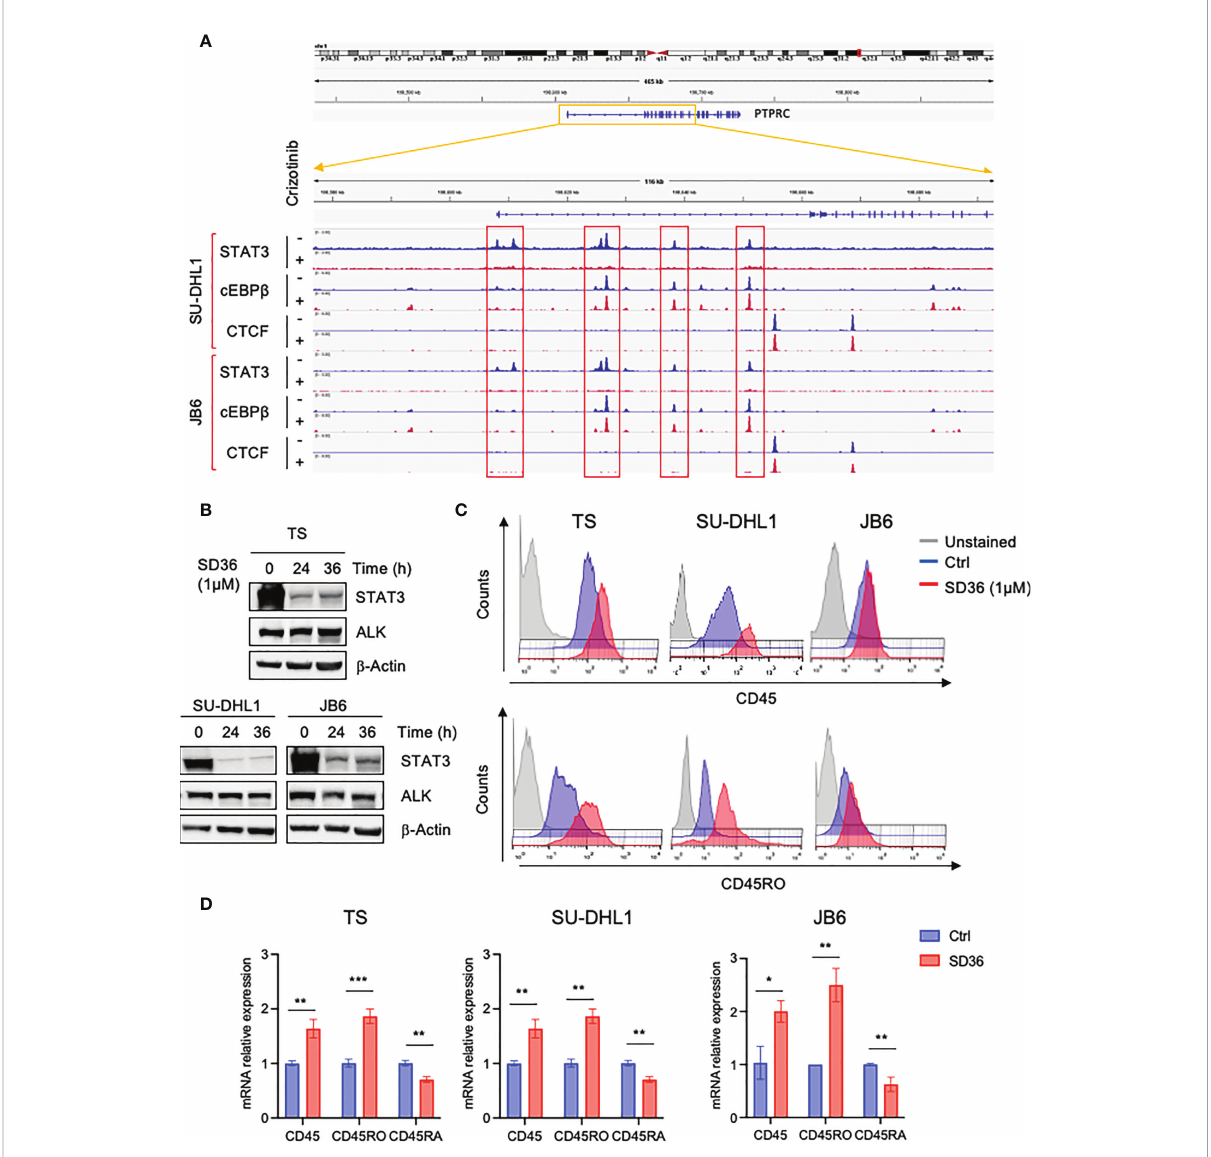
FIGURE 3 CD45 and CD45RO are derepressed by ALK via STAT3. (A) STAT3, C/EBP- b and CTCF ChIP-seq tracks at CCR7 gene on two representative ALK + ALCL human cell lines (JB6 and SU-DHL1) treated with crizotinib (300 nM) for 3h. Experiment was performed one time on two independent cell lines with similar results. (B) Immunoblot analysis performed on three ALK+ ALCL cells (TS, SU-DHL1 and JB6) treated with STAT3 degrader SD36 (1 m M) for the indicated time-points. Total cell lysates were blotted with the indicated antibodies. b -actin was used as a loading control. A representative Western blot out of two is shown for each cell line. (C) CD45 and CD45RO cell surface expression intensity in ALK+ ALCL cell lines (TS, SU-DHL1 and JB6) treated with STAT3 degrader SD36 (1 m M). TS and JB6 cells were treated for 48h and SU-DHL1 for 36h. A representative experiment out of two is shown for each cell line. (D) qRT-PCR analysis of CD45, CD45RO, CD45RA mRNA expression performed on ALK+ ALCL cell lines treated with STAT3 degrader SD36 (1 m M) for 36h. n=3 technical replicates. Data are shown as mean ± s.d. *P<0.05, **P<0.01, ***P<0.001. Signi fi cance was determined by unpaired, two tailed Student ’ s